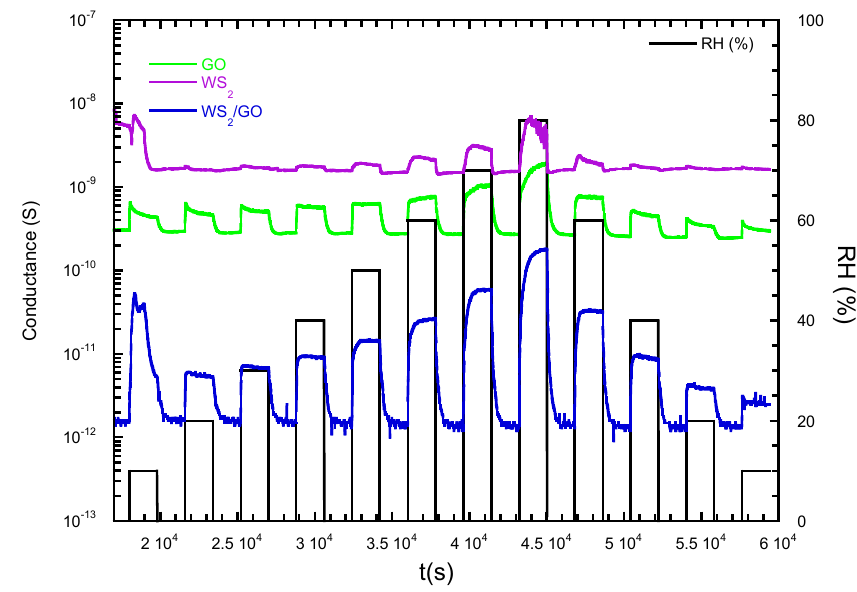
Figure 1. Conductance variations of GO, 2D WS 2 and GO/2D WS 2 sensors subjected to various pulses of humidity with RH values ranging from 0% to 80% at room